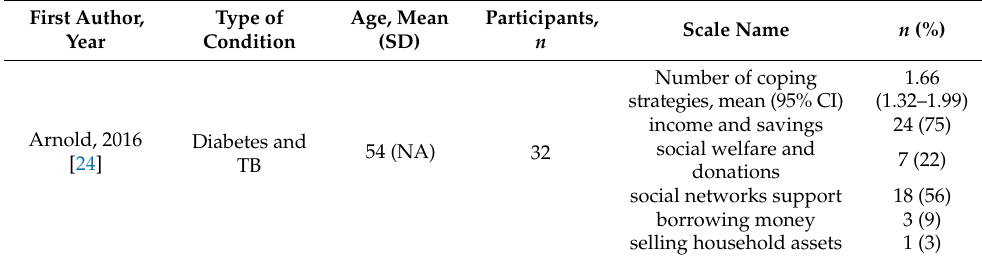
Table 11. Financial coping